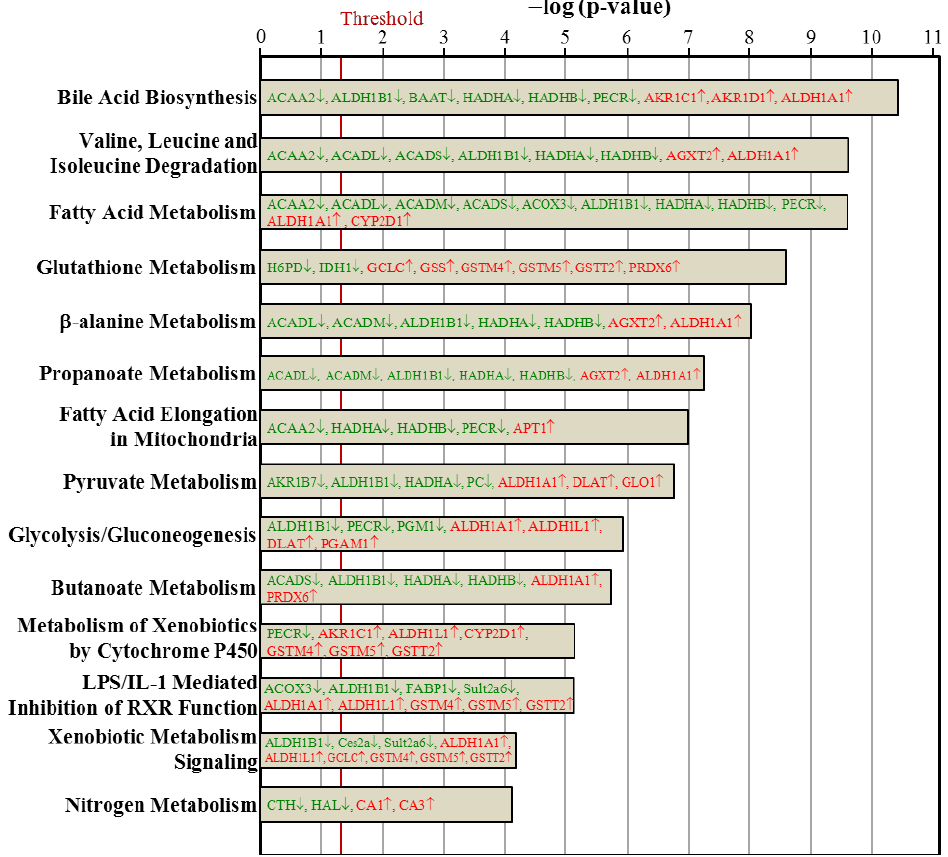
Figure 5. Comparison of canonical signaling pathways between the Ovx and Sham groups. The significantly enriched canonical pathways are displayed as a bar chart. Only the 14 most different pathways are shown, ranked by the significance in the Ovx group. The vertical line indicates a threshold of p < 0.05. Significantly enriched canonical pathways were determined by ingenuity systems pathways analyses and are displayed along the left y -axis. The x -axis displays the negative log of the p -value (blue bars), calculated by the right-tailed Fisher exact test.